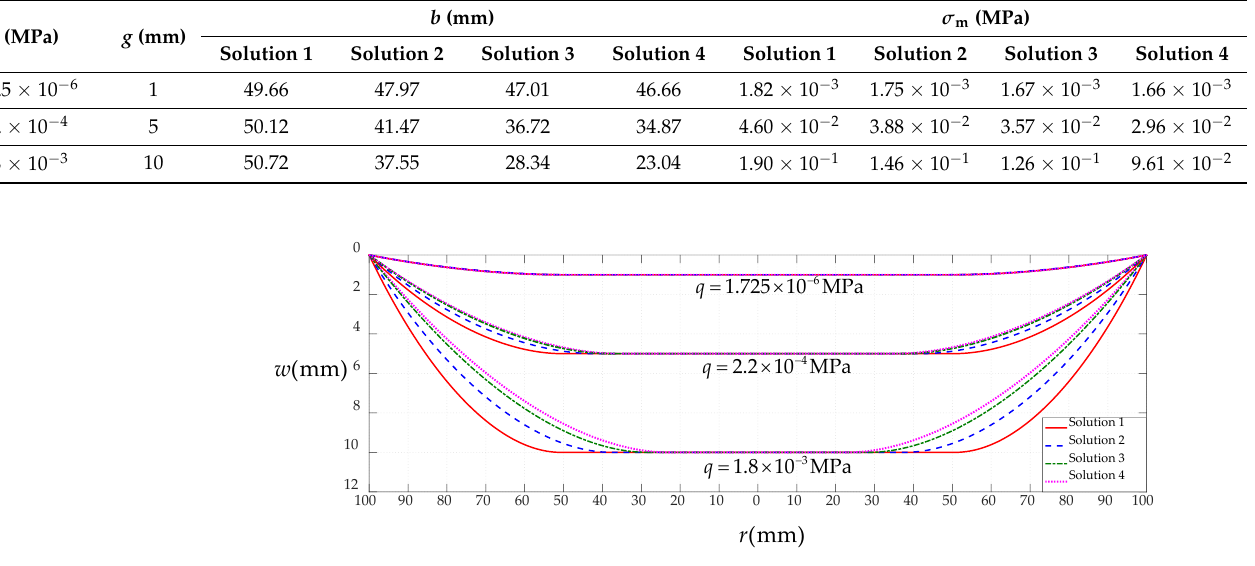
Figure 11. The variations of deflection w with radial coordinate r .